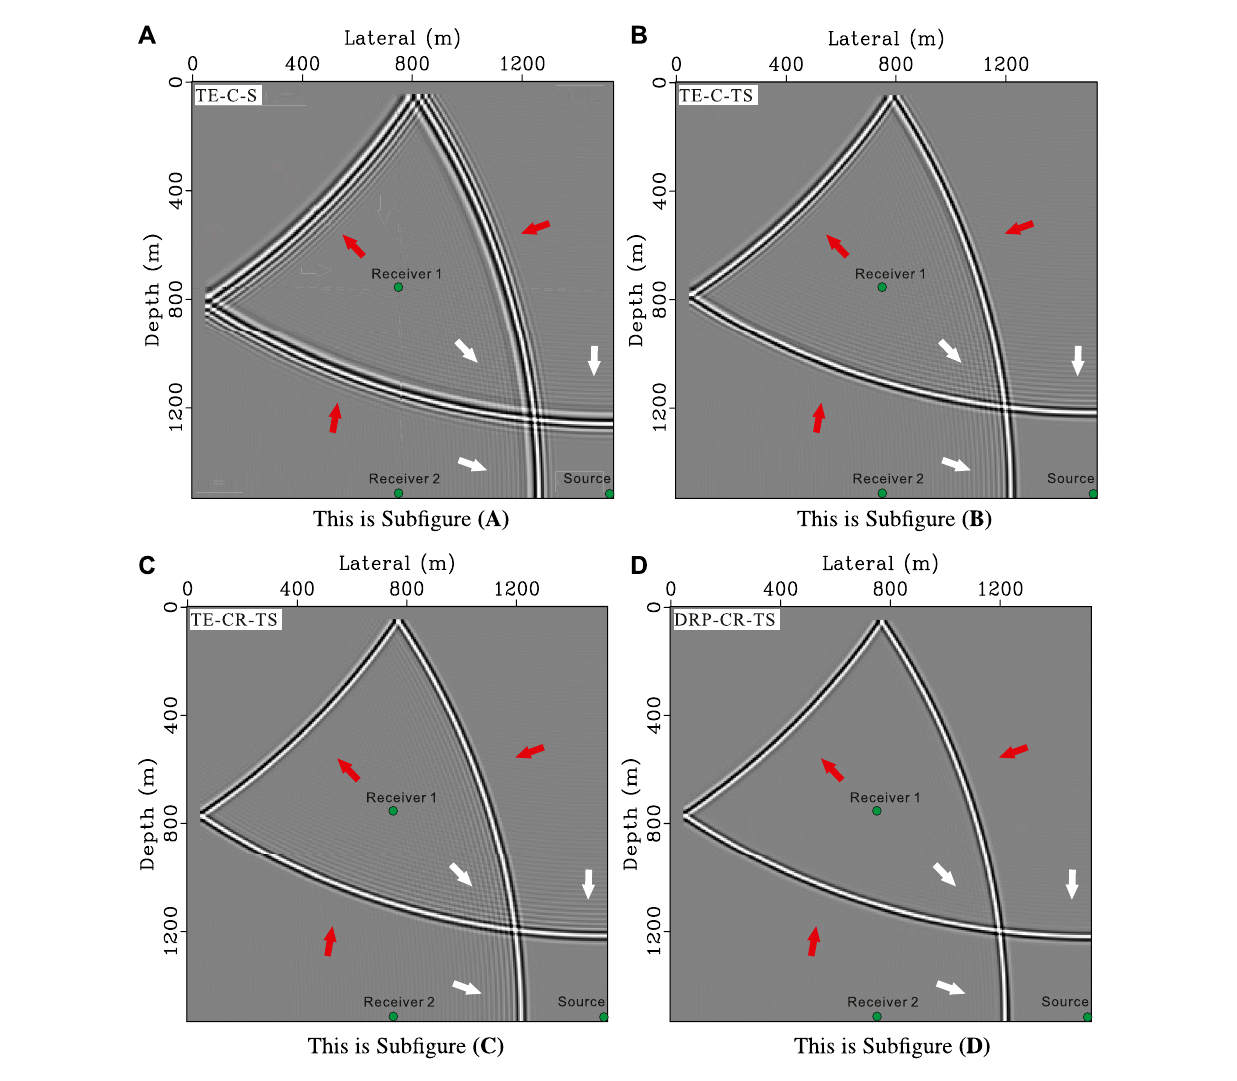
FIGURE 5 Snapshots of the four methods with the time step τ = 0.001 s , where M = 8 , N = 3 , L = M , υ = 1500 m / s and h = 6 m . The main frequency of the Ricker wavelet is 40 Hz . (A) TE-C-S method. (B) TE-C-TS method. (C) TE-CR-TS method. (D) DRP-CR-TS